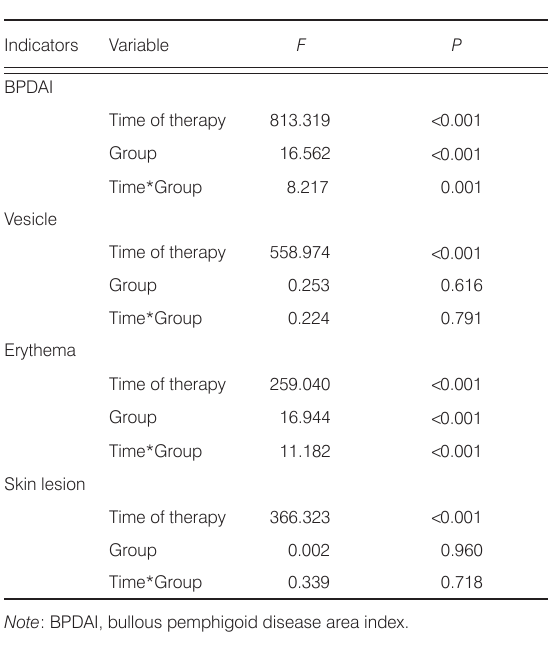
Table 2. The test of different effect of BPDAI observation index.